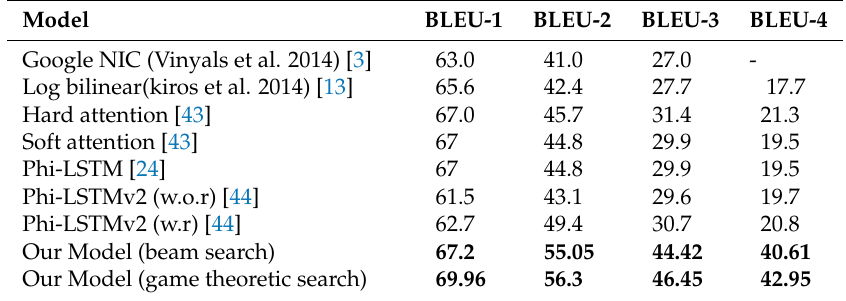
Table 6. Comparison of the BLEU scores for different models. NIC, Neural Image